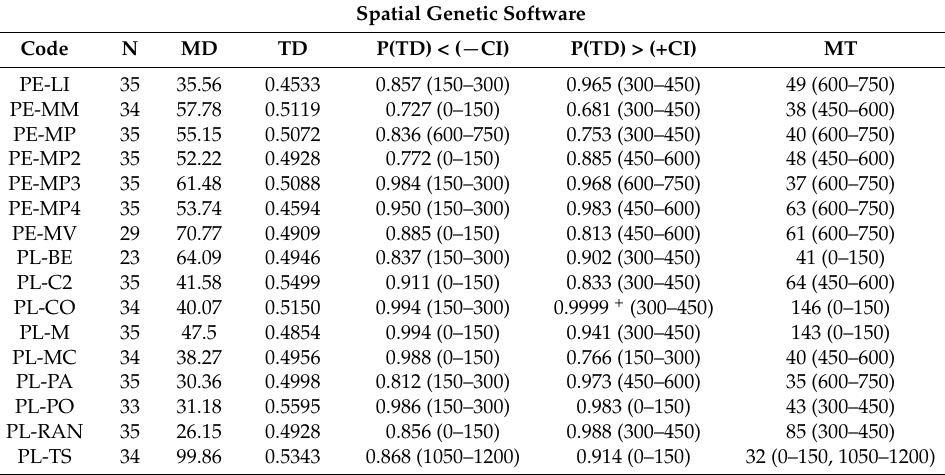
Table 2. Analysis of fine-scale spatial genetic structure in seven seed stands of Pinus engelmannii and nine seed stands of P. leiophylla using a distance class width of 150 m, 999 permutations, and a 99% confidence interval. The Tanimoto distance ( TD ) was calculated using Spatial Genetic Software 1.0 [5].